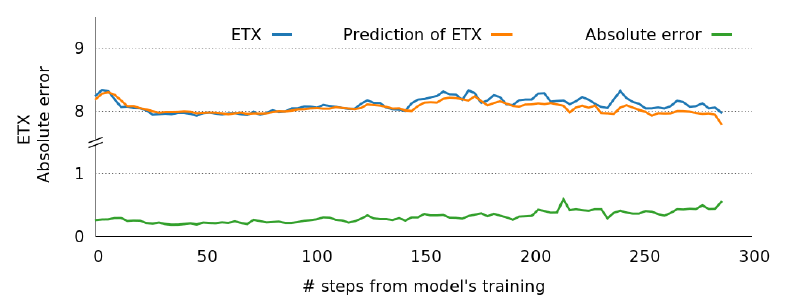
Figure 13. Evolution of the average ETX, the average prediction and the average absolute error.